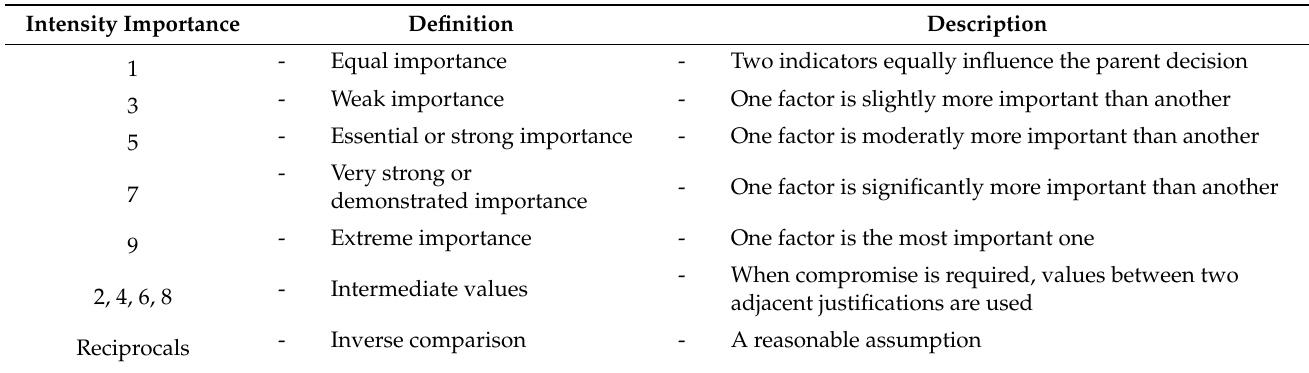
Table 1. Scale of preference for the AHP